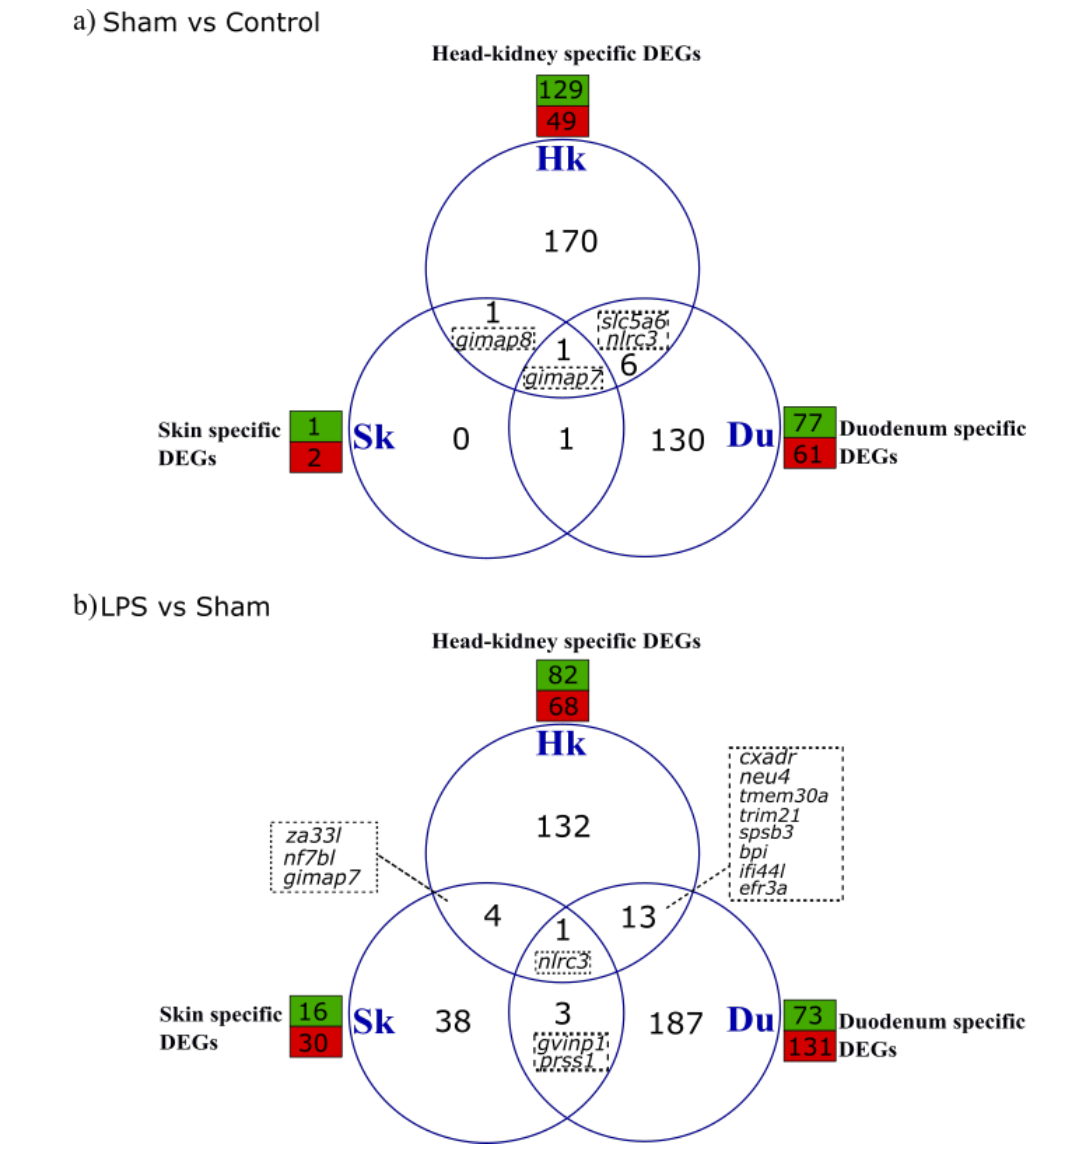
Figure 2. Venn diagram representing the number of unique and common DEGs in head-kidney (Hk), duodenum (Du) and skin (Sk) in comparisons of ( a ) Sham versus Control and ( b ) LPS versus Sham. The green and red boxes represent the total number of genes up- or down-regulated (FDR < 0.05). The dashed boxes contain the name of shared annotated gene transcripts.